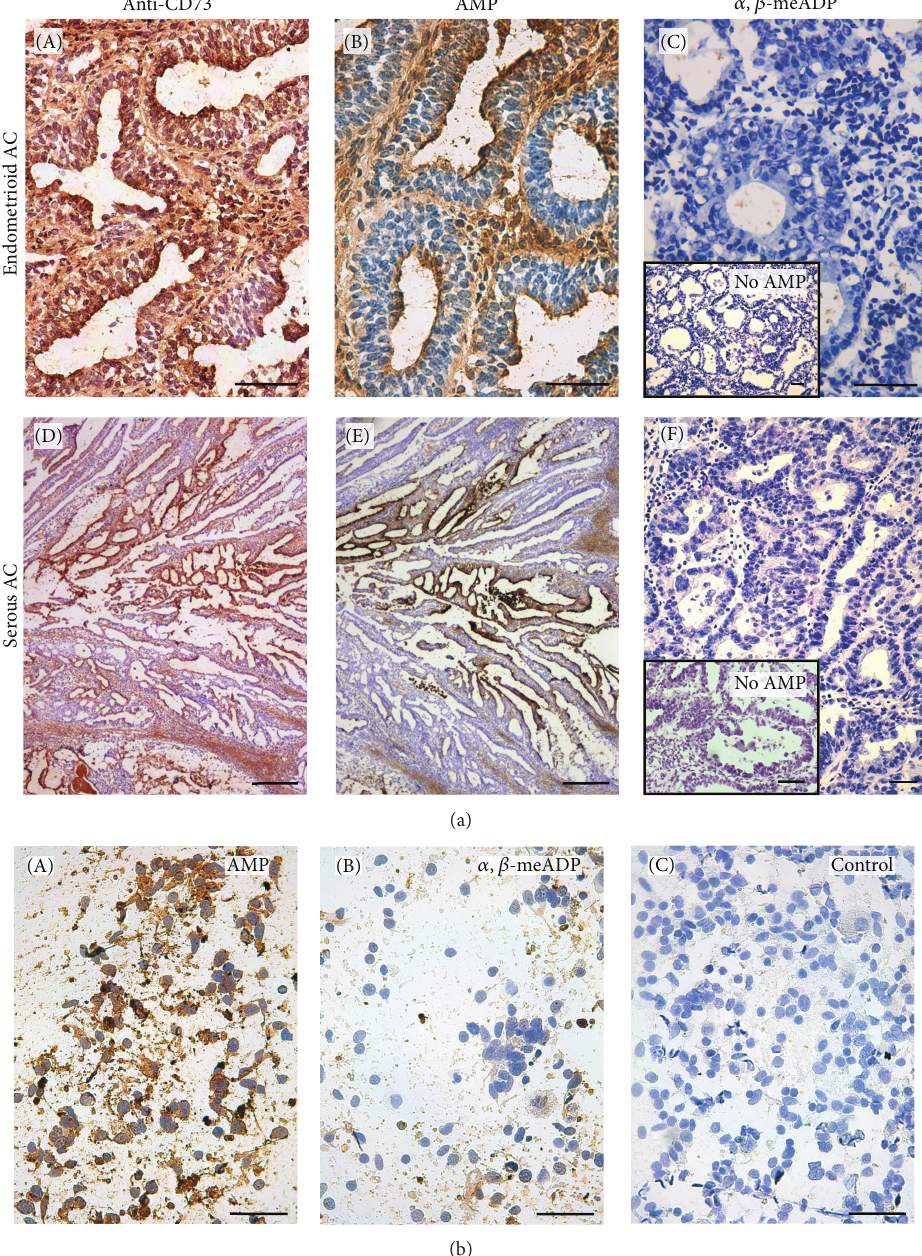
Figure 3: (a) Immunolocalization of ecto-5 󸀠 -nucleotidase/CD73 ((A), (D)) and AMPase in situ histochemistry ((B), (C), (E), and (F)) in endometrioid ((A)–(C)) and serous ((D)–(F)) endometrial adenocarcinomas. CD73 was immunodetected in glandular epithelial cells and in the stroma of both types of adenocarcinomas ((A), (D)). The AMPase activity mirrors the immunolocalization ((B), (E)). The activity was abolished in the presence of 𝛼 , 𝛽 -meADP ((C), (F)). Insets correspond to control experiments performed in the absence of nucleotide (no AMP). Scale bars = 50 𝜇 m ((A)–(C), (F), insets) and 250 𝜇 m ((D), (E)). (b) AMPase in situ activity by enzyme histochemistry in endometrial touch preparations. Dark precipitates in (A) correspond to the AMPase activity in the presence of AMP as substrate. The inhibitor 𝛼 , 𝛽 - meADP completely abolished this activity (B). Control experiments were performed in the absence of substrate (C). Scale bars = 50 𝜇